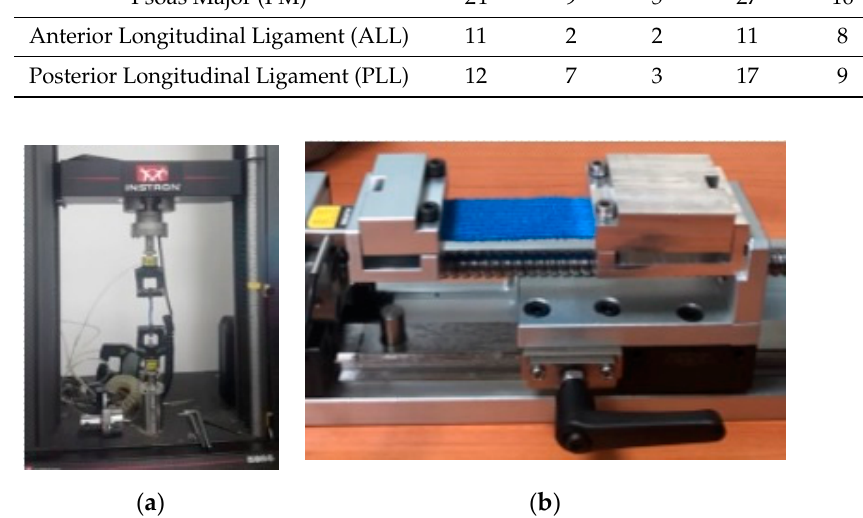
Figure 4. The test setup from ( a ) Instron, and ( b ) the Quantifying device (QD).